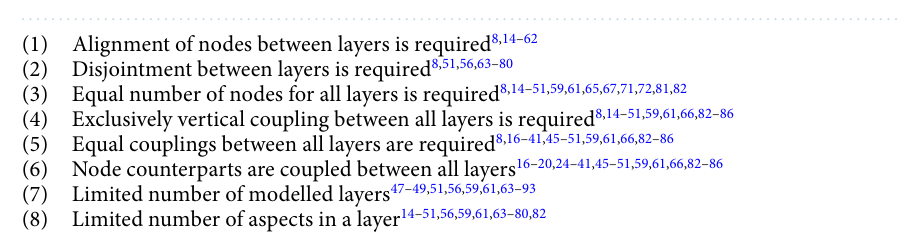
Figure 1. A topological visualizaiton of the trimetrica smart city infrastructure test case 7